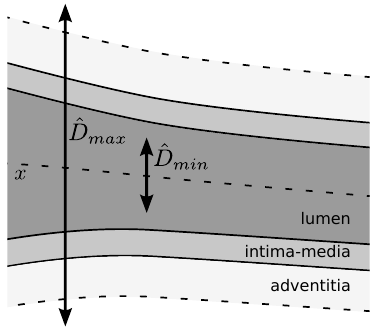
Figure 4. Scheme depicting the estimated diameter measures.